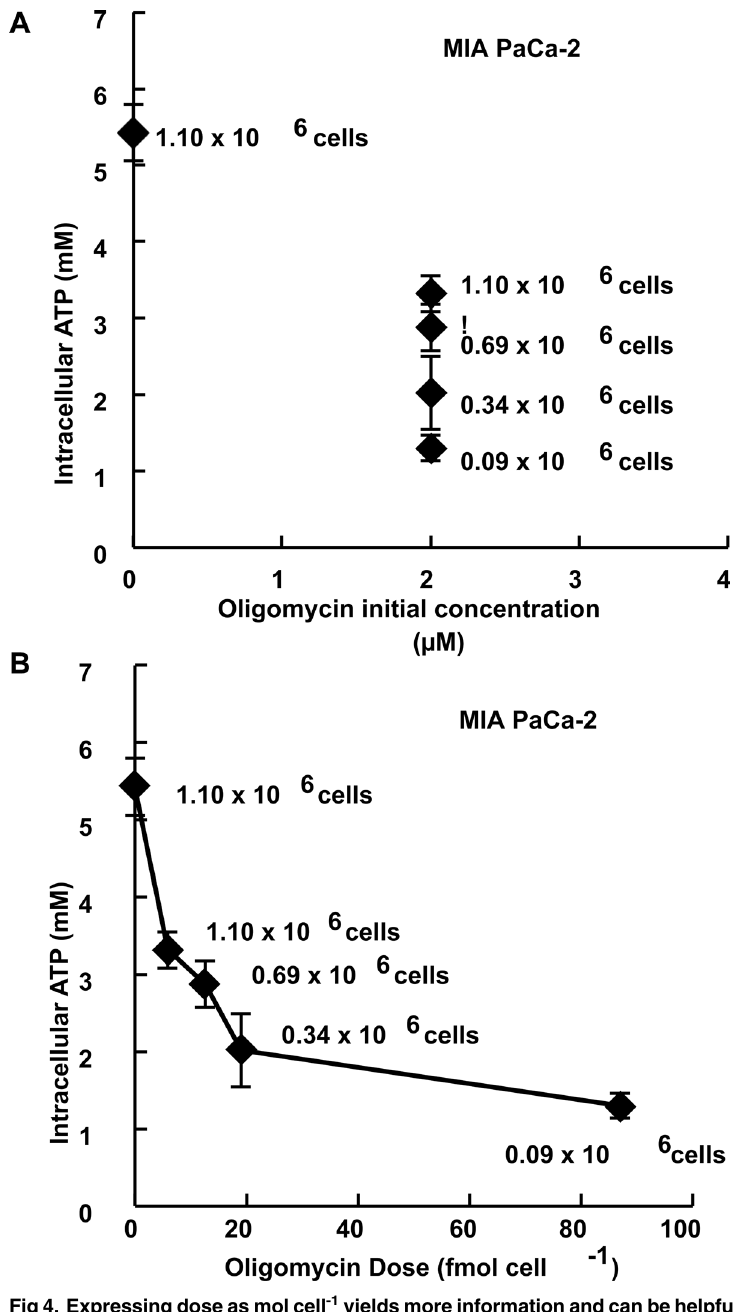
Fig 4. Expressing dose as mol cell -1 yields more information and can be helpful when using biochemical tools in cell culture experiments: ATP per cell decreases with increasing dose of oligomycin A on a per cell basis. The levels of ATP in MIA PaCa-2 cells were measured immediately after a 1-h exposure to oligomycin A. (A) ATP levels measured following a 1-h exposure of MIA PaCa-2 cells at varying cell densities to 2 μ M oligomycin A in 3.0 mL medium. Doses of oligomycin A are expressed in initial concentration of oligomycin A in the medium ( μ M) ( n = 4, error bars are standard deviation of the mean). (B) Doses of oligomycin A are expressed in mol cell -1 (fmol cell -1 ) ( n = 4, error bars are standard deviation of the mean).